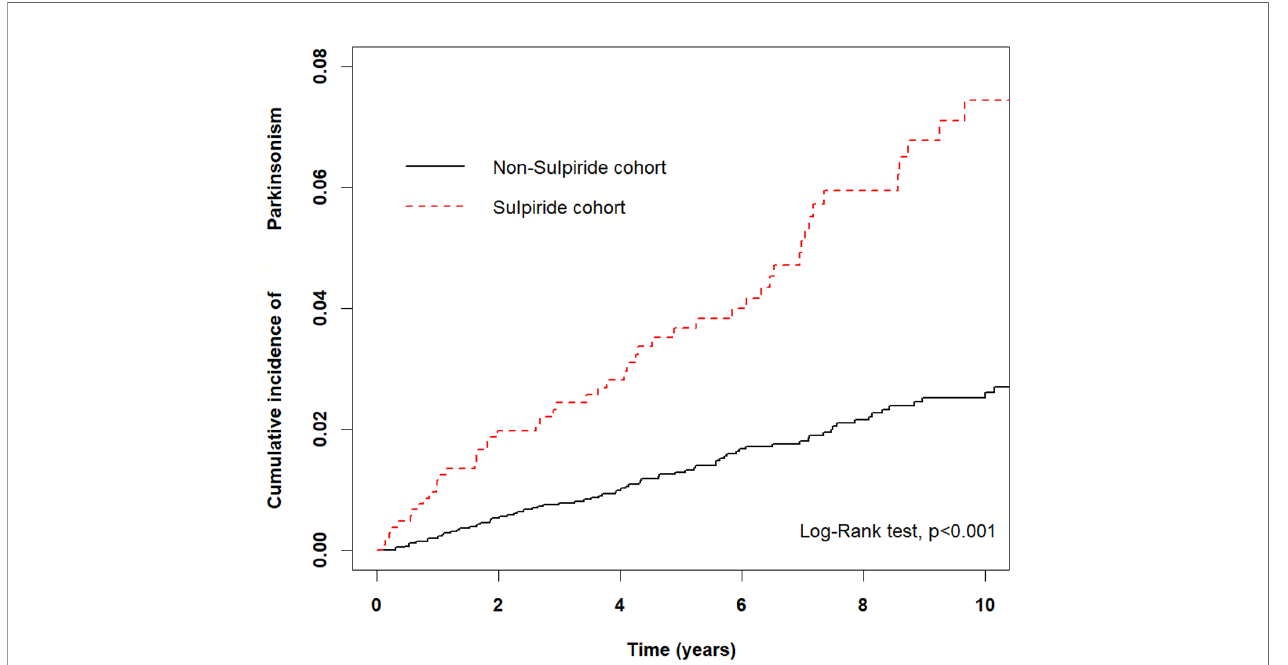
FIGURE 2 | Kaplan-Meir method to determine the cumulative incidence of parkinsonism compared between the sulpiride and non-sulpiride cohort.